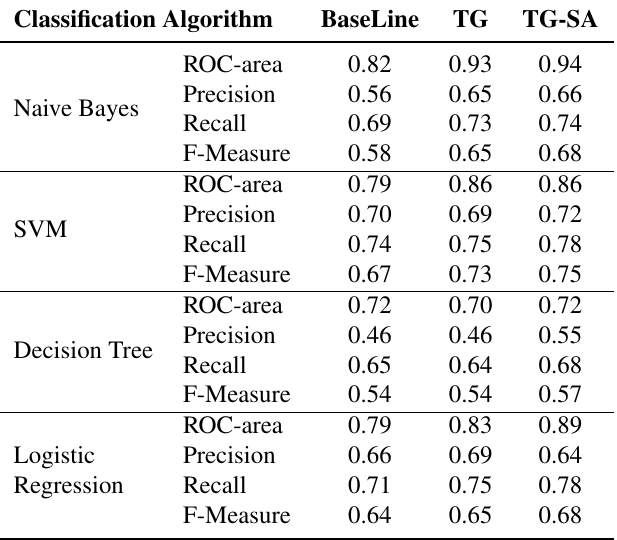
Table 4. Prediction accuracy improvement, by applying temporal granularity (TG) on timestamp and semantic abstraction (SA) on sensor data. Classification